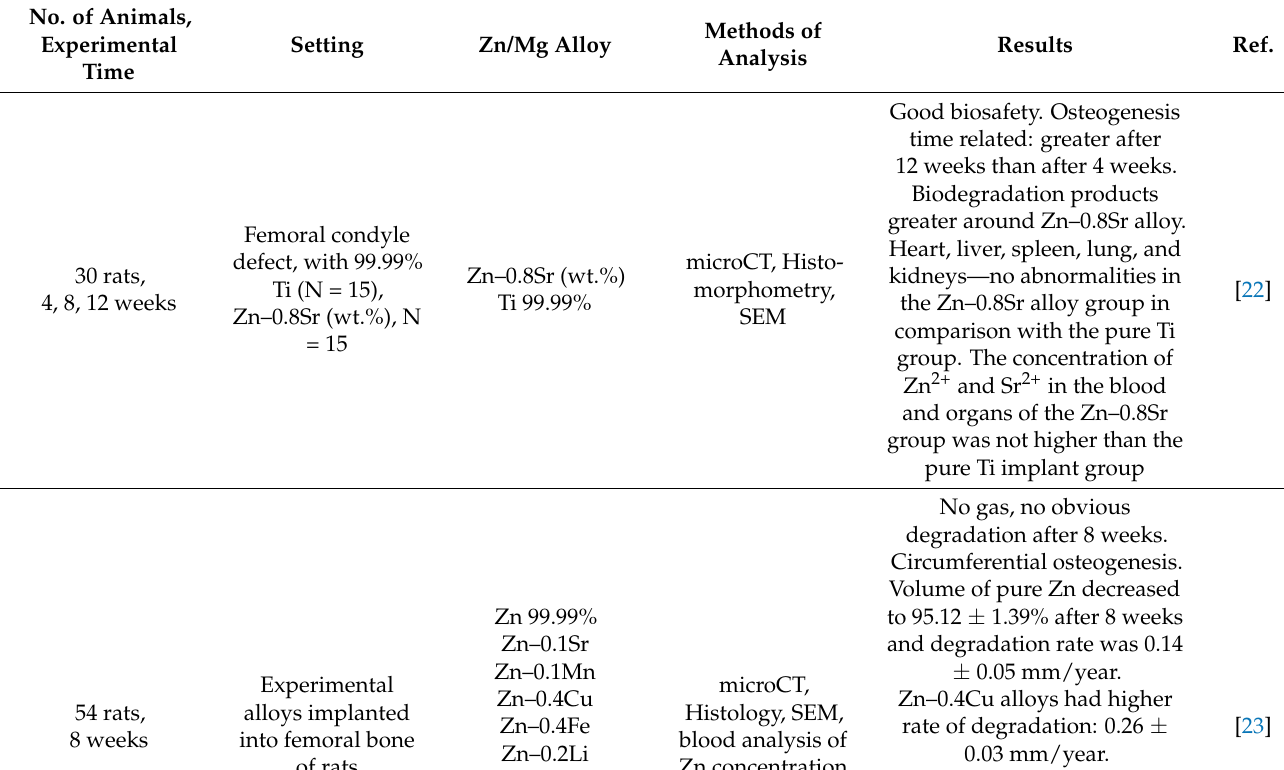
Table 1. A summary of the results of the in-vivo tests on Zn/Mg alloys performed by various scientific groups. No. of Animals, Experimental Zn/Mg Alloy